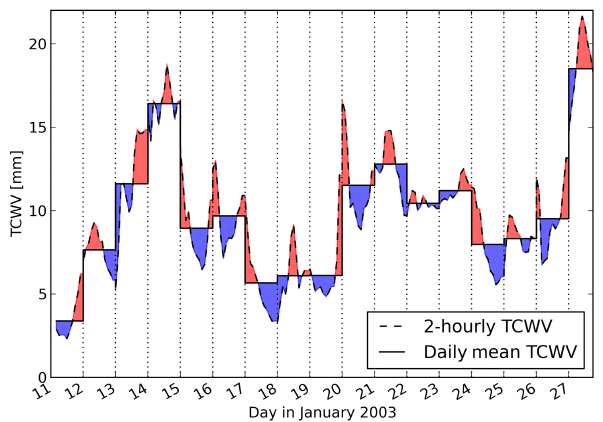
Figure 8. GNSS TCWV for 16 days in January 2003 at the station Potsdam (POTS) in blue. Daily average TCWV in black. Anomalies are coloured (positive: red,